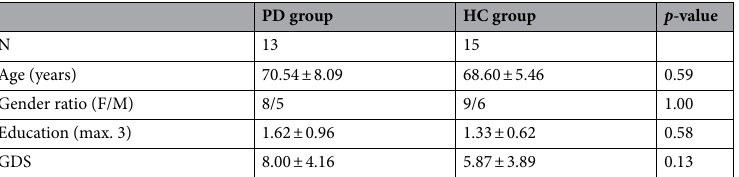
Table 1. Demographic and clinical characteristics of the participants. Mean ± SD are reported in the table. Statistical analyses were performed using Wilcoxon Mann–Whitney tests [for age, education and GDS score] and Fisher tests [for gender]. GDS geriatric depression scale, PD Parkinson’s disease patients, HC Healthy